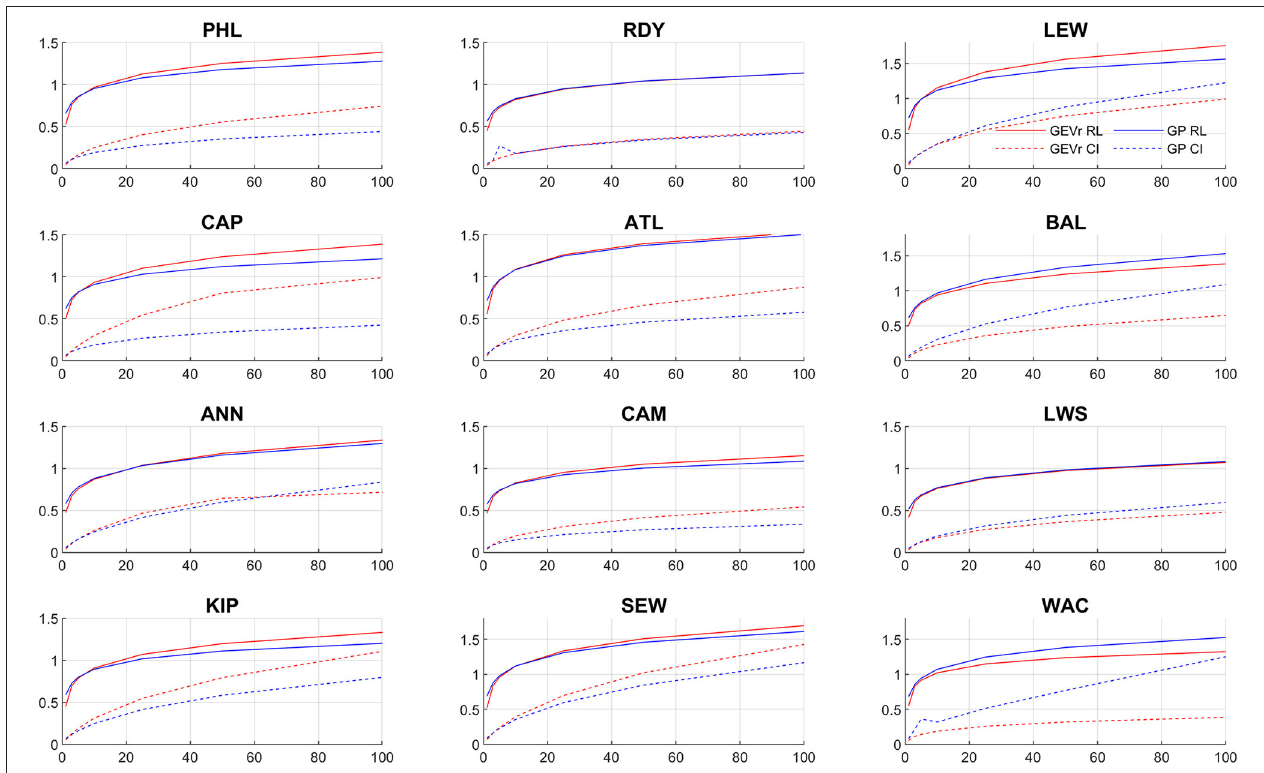
FIGURE 6 | Estimated return levels (solid line) and 90% confidence intervals (dotted line) using the BM/GEVr (red line) and POT/GP (blue line)